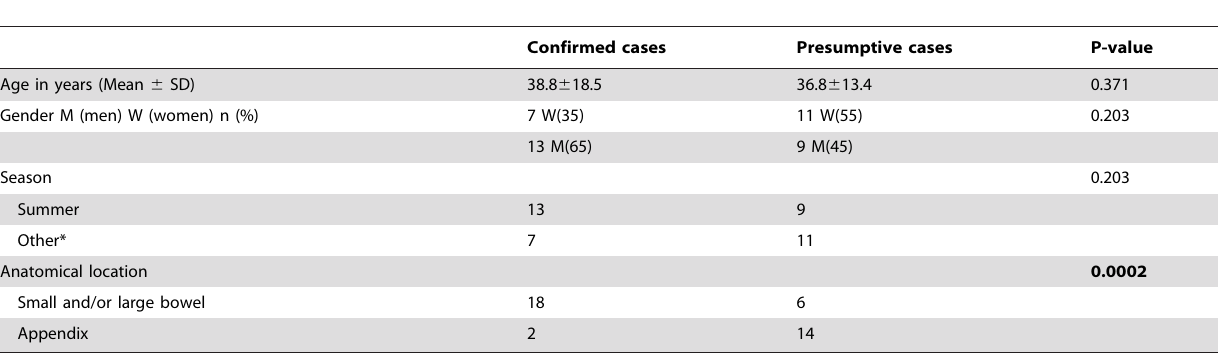
Table 1. Demographic and clinical characteristics of confirmed (n =20) and presumptive cases (n=20) of abdominal angiostrongyliasis.